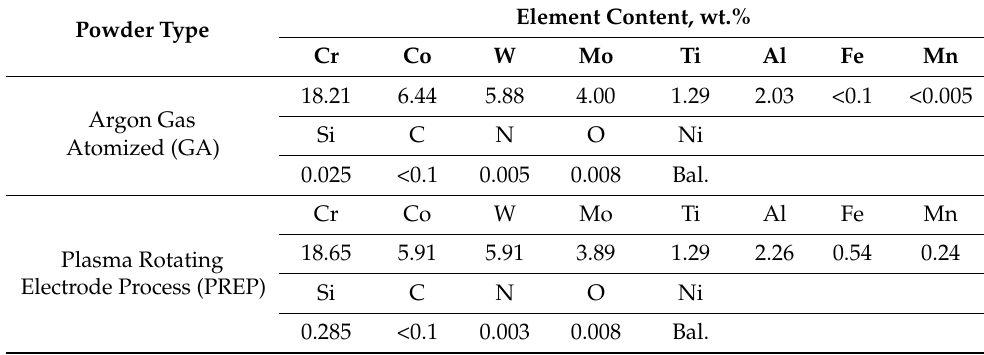
Table 1. Chemical composition of GA and PREP powders of GH4099 (wt.%).